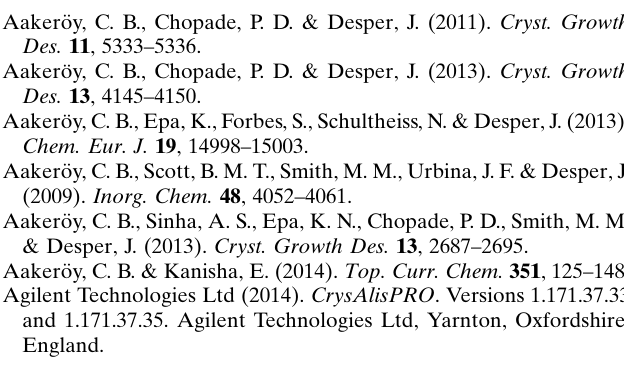
Fig. 14 c and supplementary Fig. S19). In the case of forming the catemeric motif C (4), again unfavourable contacts are to be expected (Fig. 14 f ).